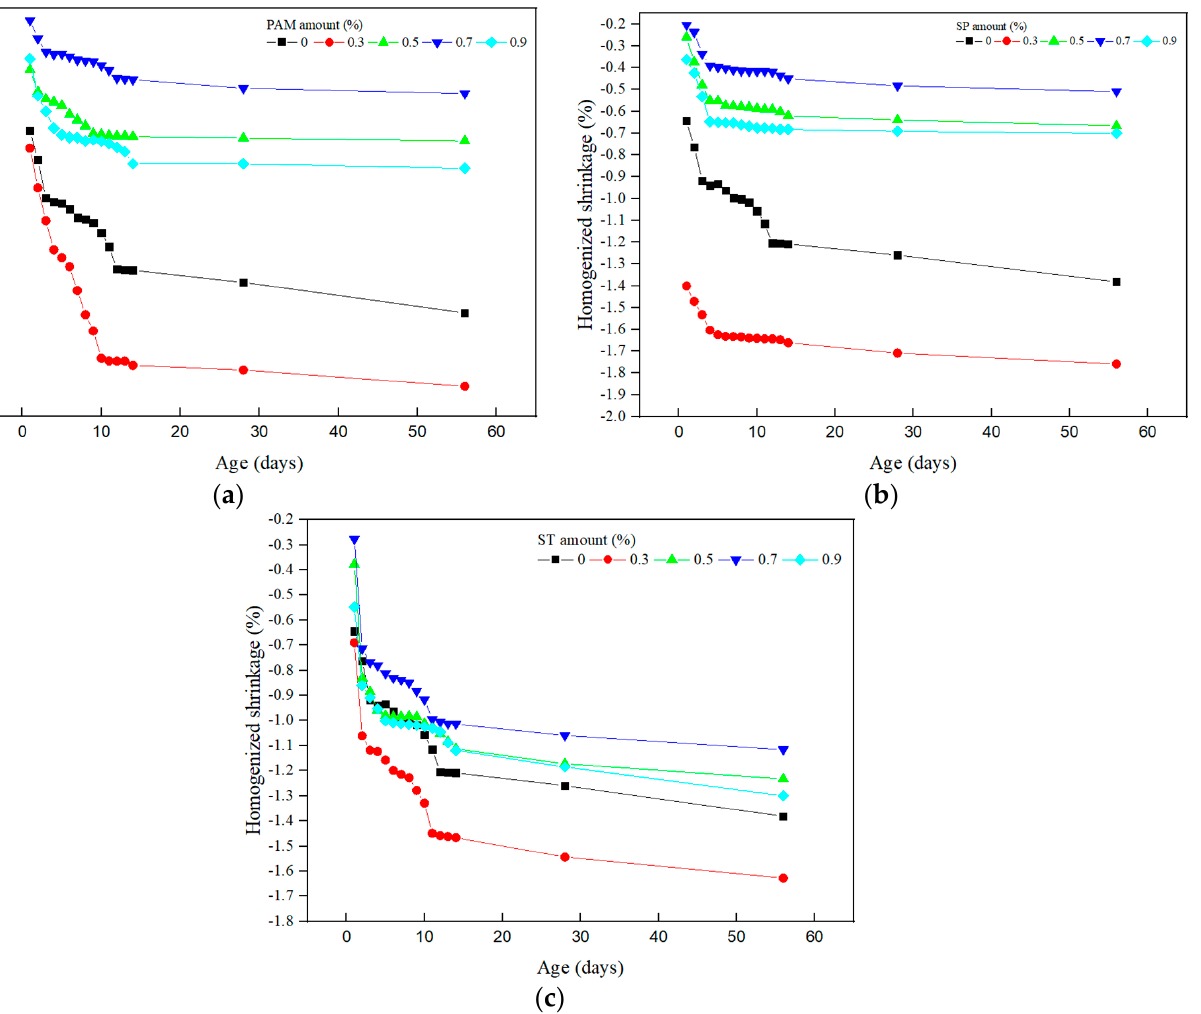
Figure 6. Drying shrinkage change after adding different SAPs. ( a ) Drying shrinkage for different additions of PAM. ( b ) Drying shrinkage for different additions of SP. ( c ) Drying shrinkage for different additions of ST.